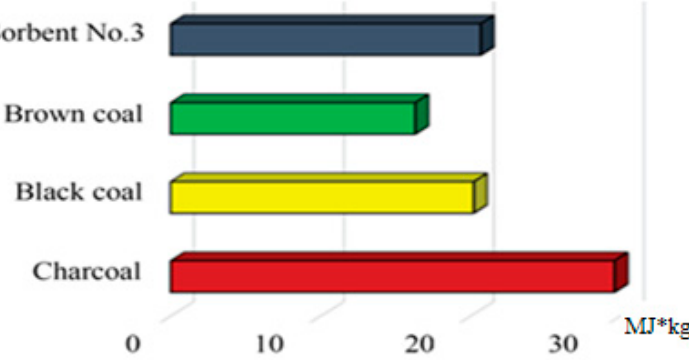
Figure 10. Specific combustion heat depending on the fuel type.